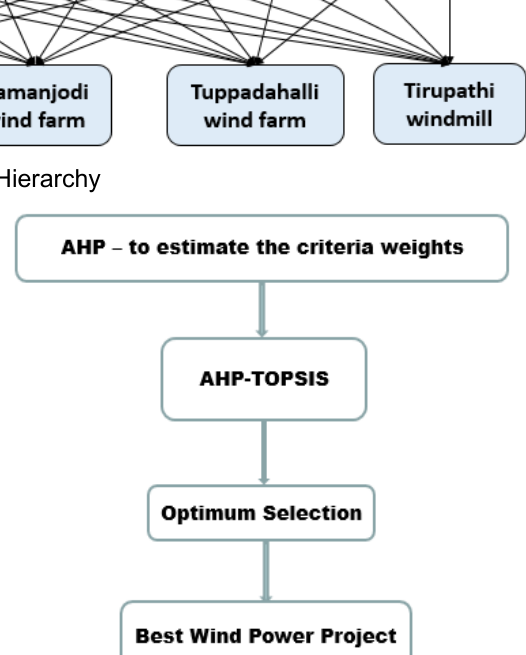
Figure 2. Step by Step procedure for selection of wind power